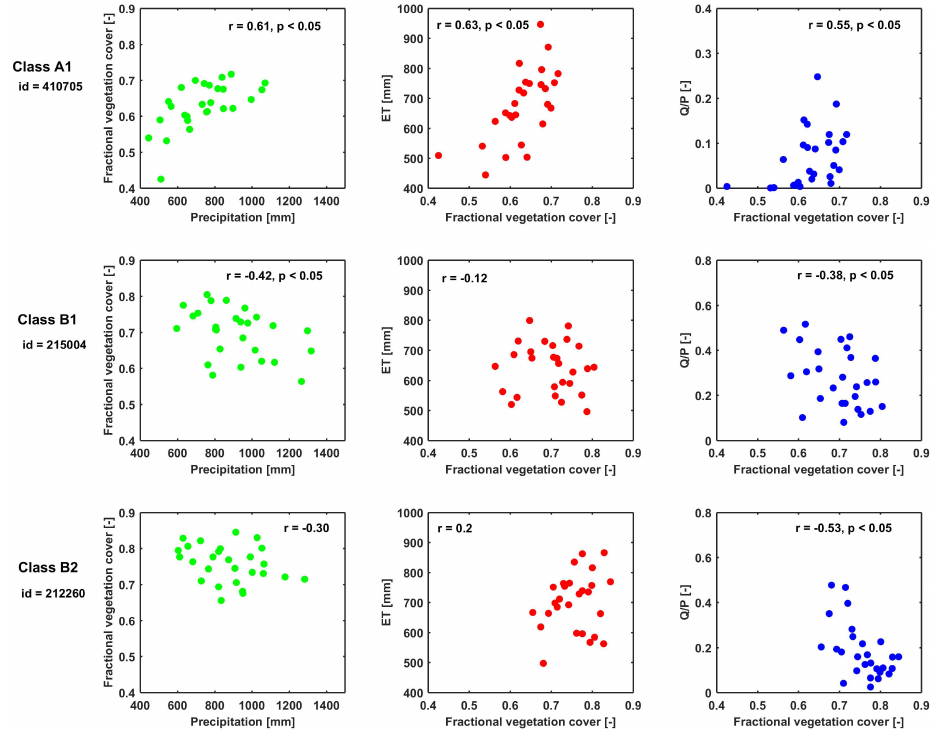
Figure 7. Relationships between catchment-averaged annual fractional vegetation cover and annual precipitation (left), water-balance-derived annual ET (middle) and runoff ratio (right) against mean annual fractional vegetation cover (1984–2010) across three catchments represen- tative of each class in Fig. 6. The Spearman rank correlation ( r ) and p values are shown when correlation is significant.